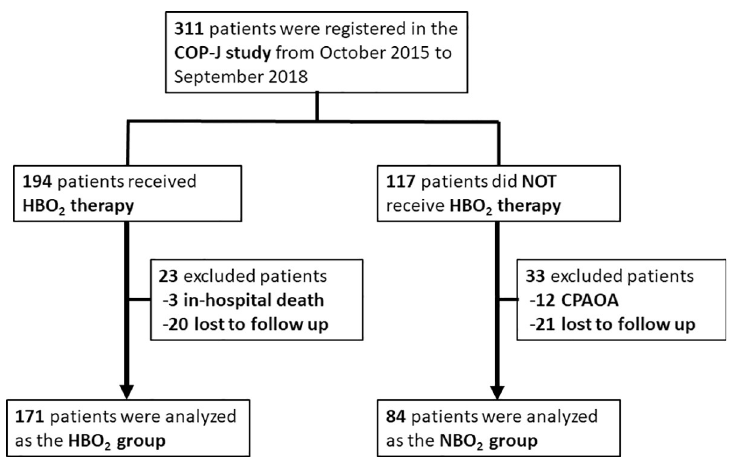
Fig 1. Flowchart of patient selection. HBO 2 , hyperbaric oxygen; NBO 2 , normobaric oxygen; CPAOA, cardiopulmonary arrest on arrival.